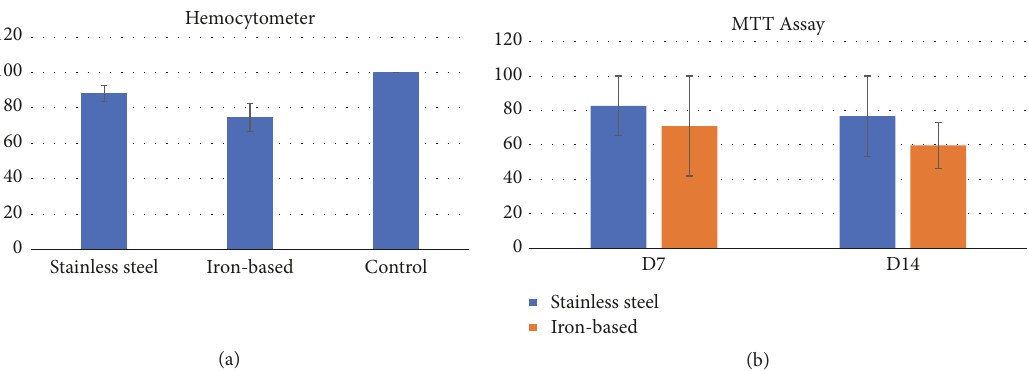
Figure 2: Calf pulmonary artery endothelial cell viability of iron-based and stainless steel implant using (a) haemocytometer and (b) MTT Assay.